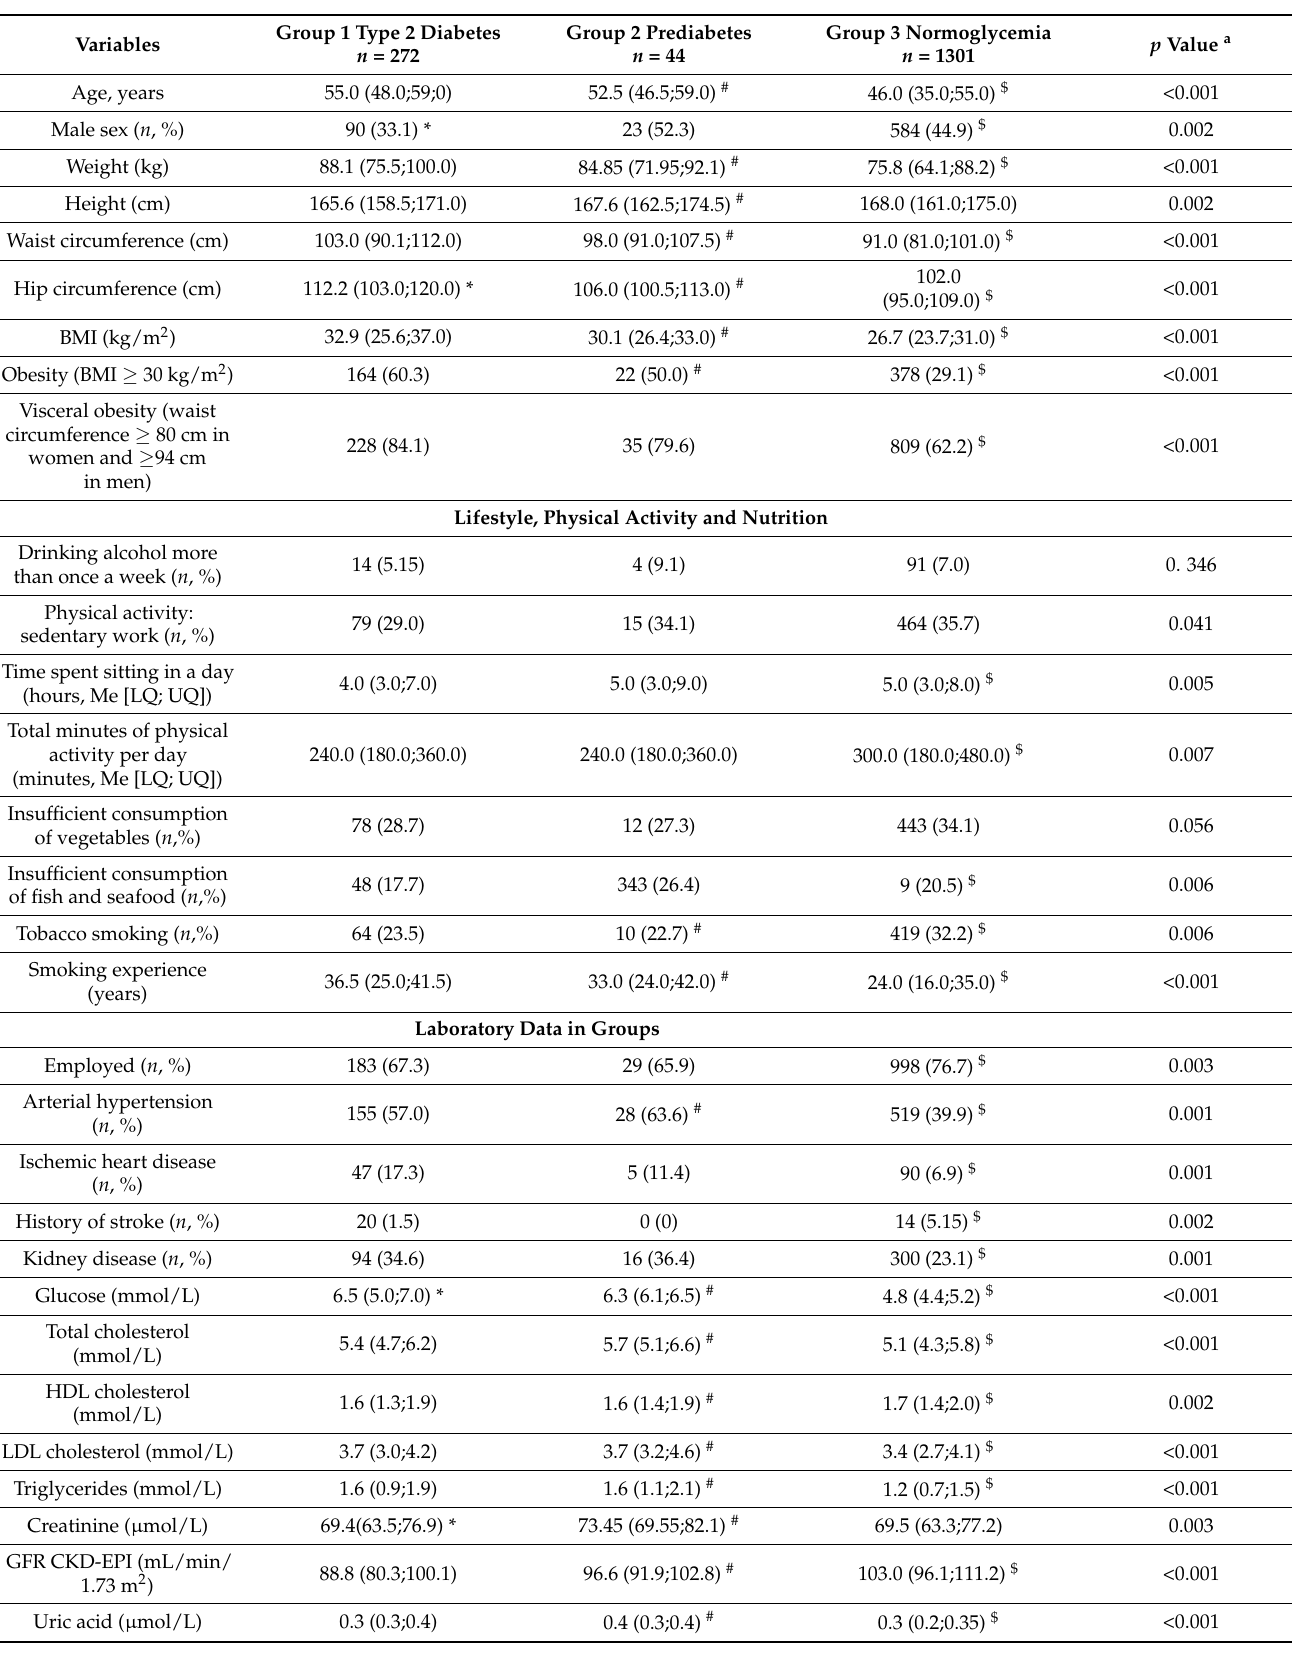
Table 1. Baseline characteristics of the study groups ( n =